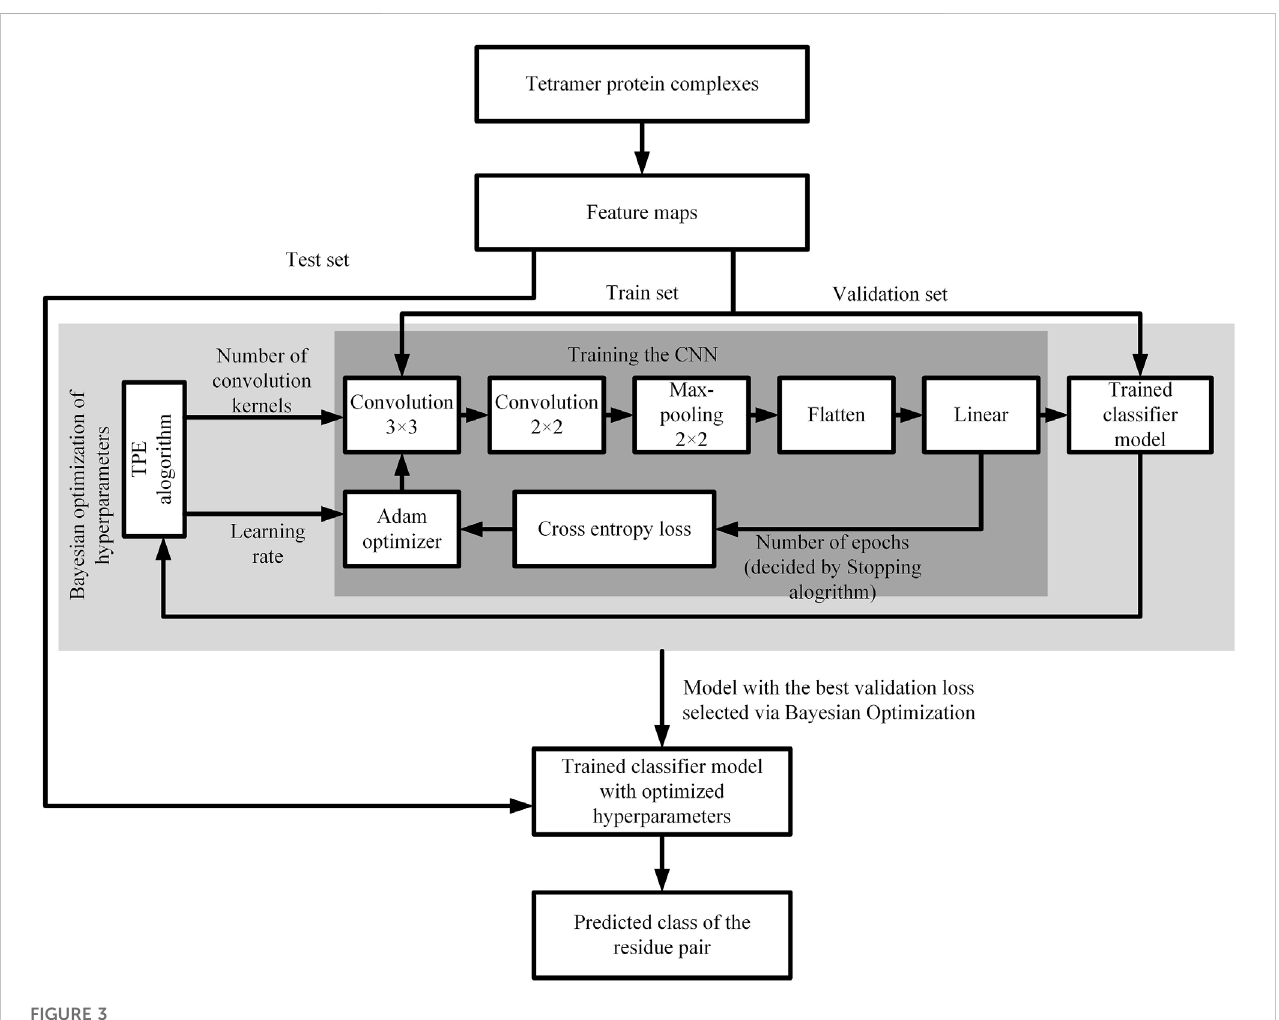
FIGURE 3 Flow chart of the CNN